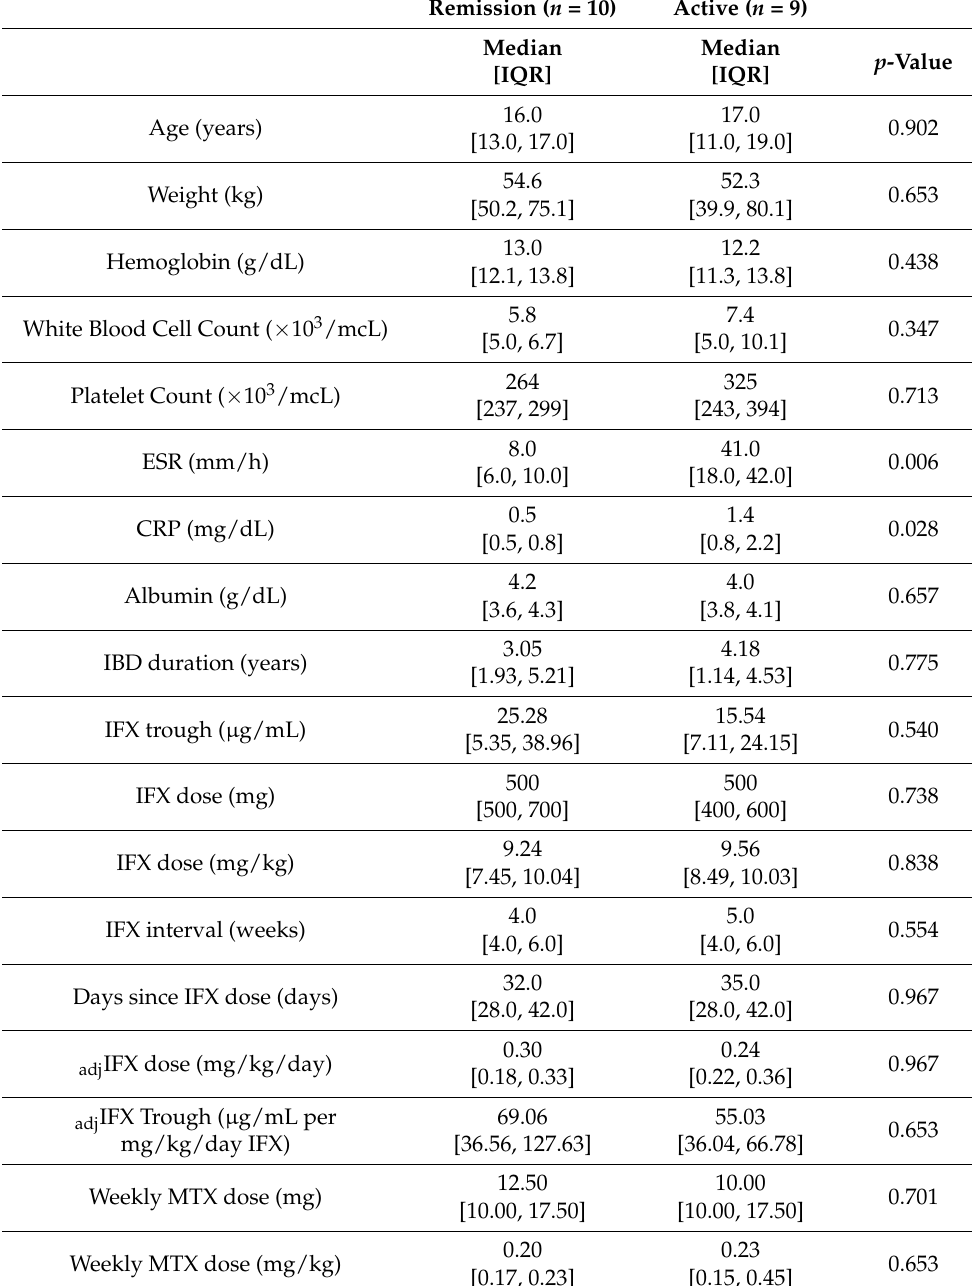
Table 2. Patient characteristics for children with Crohn’s disease: IFX: infliximab, MTX: methotrexate, adj IFX: dose or concentration adjusted for mg/kg IFX received and time since drug administration. All patients received weekly